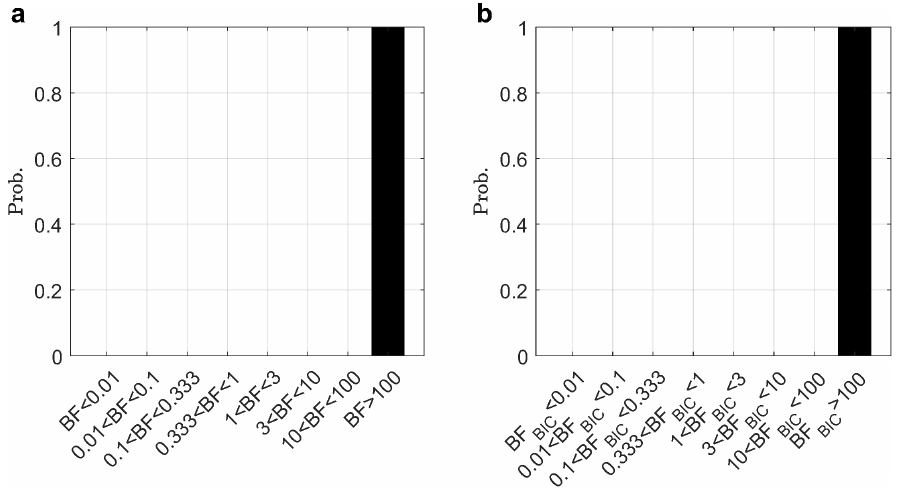
Figure 11. Histogram of Bayesian Factor. ( a ) Bayesian Factor without the Bayesian Information Criterion BF . ( b ) Bayesian Factor with the Bayesian Information Criterion BF BIC